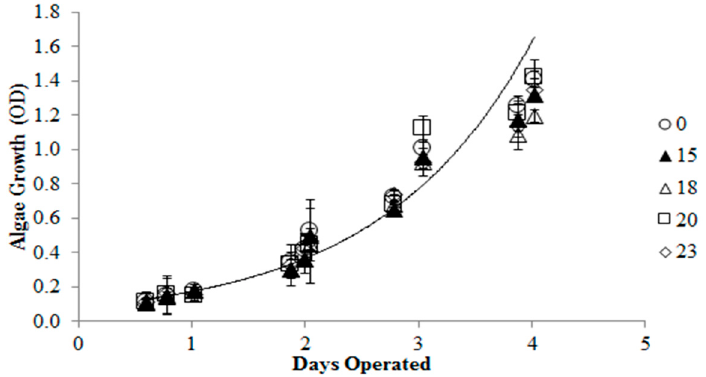
Figure 2. Effect of quinine sulfate (0, 15, 18, 20, 23 uM) on C . kessleri .